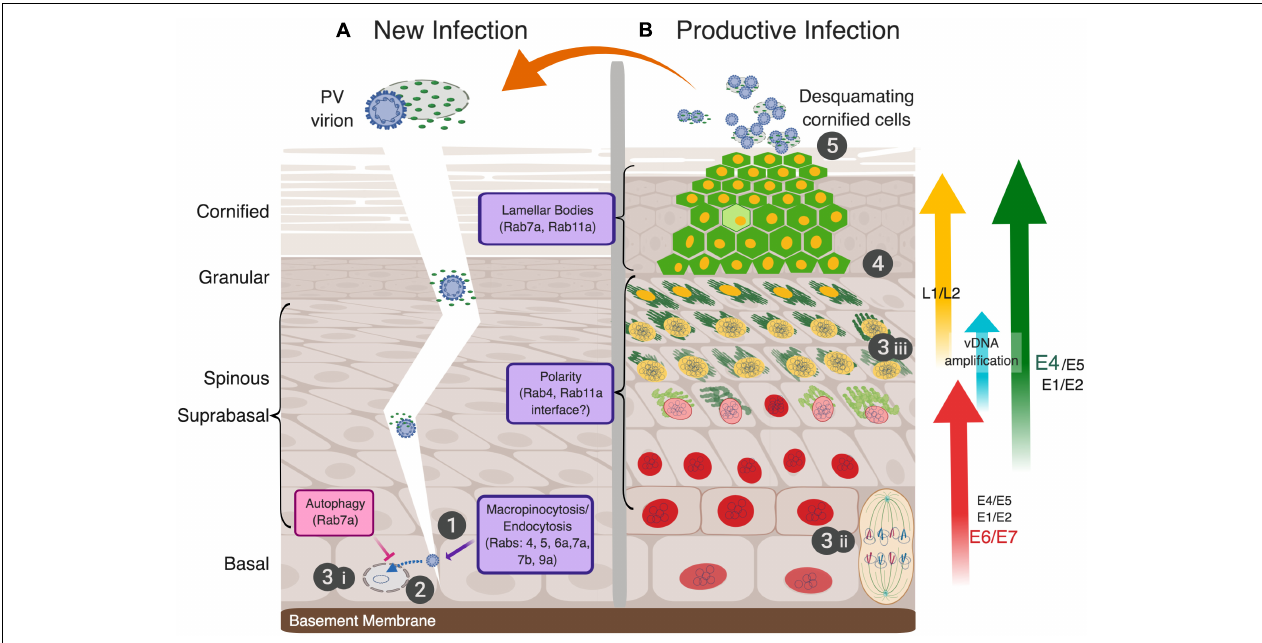
FIGURE 2 | The full papillomavirus replicative-cycle requires stratifying and differentiating epithelium. The five canonical steps of virus infection as shown numbered (1-attachment, 2-entry, 3-genome replication, 4-assembly, 5-release). (A) Infectious virions (blue-studded, circular particles shown encapsidating the cell histone-bound double-stranded vDNA) in the context of desquamating cornified cells (DCCs) gain access to replication competent, mitotically active basal cells via an epithelial barrier breach to attach and initiate a new infection (step 1). Whether cellular or soluble virus factors, e.g., the viral E4 protein, play an active role in infection is unknown (depicted as a fragile DCC with viral E4 shown as small green ovals). As discussed in the text, PVs use endocytic vesicles for virion uptake to transport the viral genome to the nucleus (step 2), and thus, interface with Rab proteins directly and indirectly (noted in the lowest purple box). The first phase of viral genome replication in the nucleus is thereafter initiated (step 3i). (B) A simplified view of viral gene expression during a persistent infection, which is tightly linked to epithelial differentiation, is illustrated and explained more fully in the text. The epithelial layers are morphologically characterized as basal, spinous, granular, and cornified cells, above the basement membrane (left of panel A). The viral genome (shown as small, intranuclear blue circles) is replicated in three separate stages (steps 3i–iii): (3i) establishment , where the incoming viral genome is replicated to 10–50 copies per nucleus; (3ii) maintenance , wherein viral genomes are replicated with cellular DNA and partitioned into daughter cells mediated by E2 linkage to mitotic chromosomes; and (3iii) amplification in the upper suprabasal cell layers in preparation for the assembly of progeny virions. These three phases of vDNA replication, as well as early and late viral gene expression, are separated temporally and spatially in the productively infected epithelium (reviewed in Ozbun and Meyers, 1999; Graham, 2010). Expression of viral proteins denoted as E1, E2, E5, E6, and E7 are modulated during infection (Doorbar et al., 2012; Graham, 2017). Potential sites of viral interface with Rab proteins with epidermal functions in the suprabasal and granular layers are indicated with purple boxes. Red nuclei represent infected cells expressing the E6 and E7 proteins, cytoplasmic green represents E4 protein amyloid fibrils, with increasing green darkness representing increased expression levels. E4 plays an essential role in aiding virus release by disrupting cytokeratins to compromise the integrity of DCCs. Yellow nuclei demark the expression of capsid proteins L1 and L2, which encapsidate the vDNA into newly assembled virions (step 4). Infectious progeny virions are released from the apical layer of the epithelium associated with fragile DCCs to initiate a new round of infection (step 5). Image created with